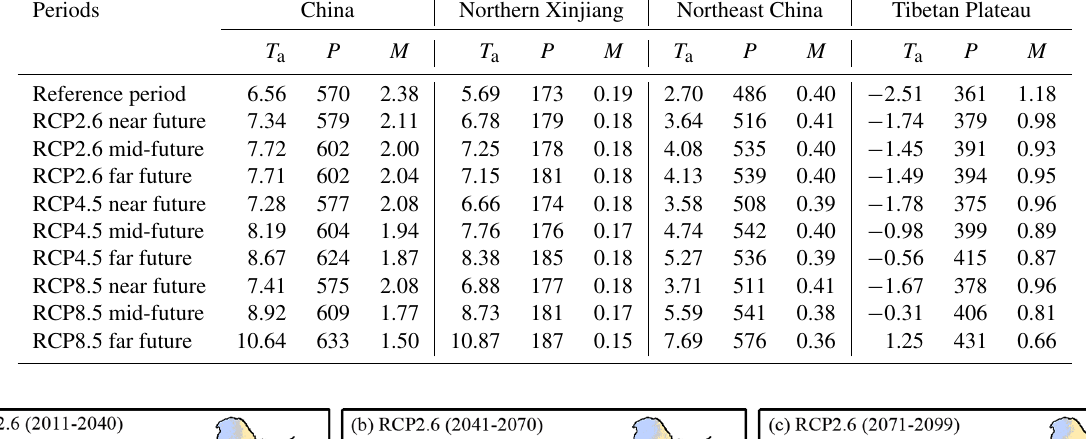
Table 4. Changes in mean annual air temperature ( T a ; degrees Celsius), precipitation ( P ; millimeters) and snowmelt ( M ; × 10 11 m 3 ) in China and its three main stable snow cover regions during the reference period (1981–2010), near future (2011–2040), mid-future (2041–2070) and far future (2071–2099) under the three representative concentration pathways (RCPs).